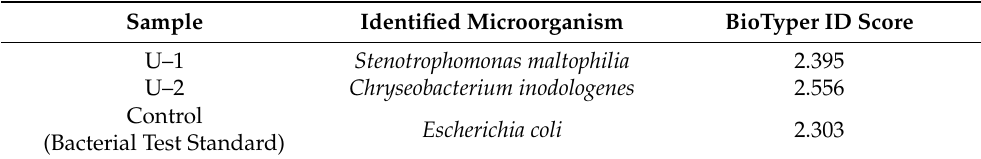
Table 2. Contaminant bacteria identified from microsomes by MALDI-TOF/TOF analysis and associated BioTyper ID